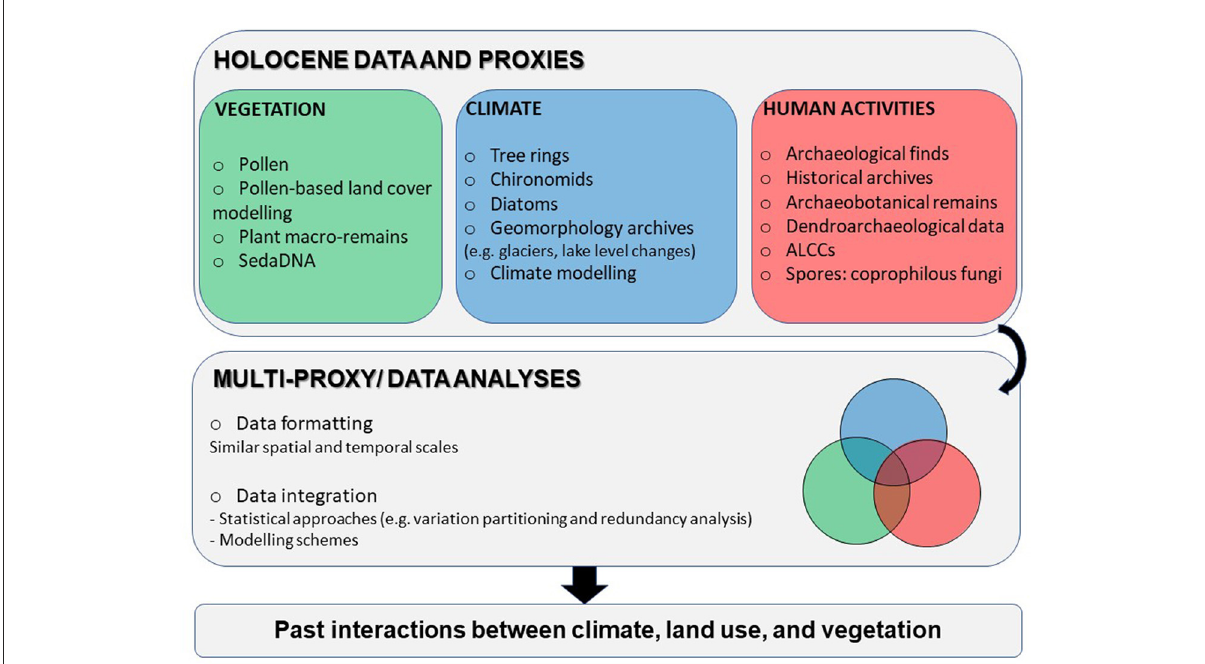
FIGURE1 Conceptual diagram showing the potential of multi-proxy/data analyses to assess past interactions between climate, land use, and vegetation (ALCCs, model-derived anthropogenic land-cover change scenarios). Note that single proxies can simultaneously provide information for more than one category, e.g., tree rings can be used to infer past vegetation, climate variability and forest management practices or pollen data can be used to infer past climate and land use. However, for data integration one should use independent variables to avoid circular reasoning, therefore, we do not duplicate the use of proxies/data in this figure. This can be adjusted depending on the study